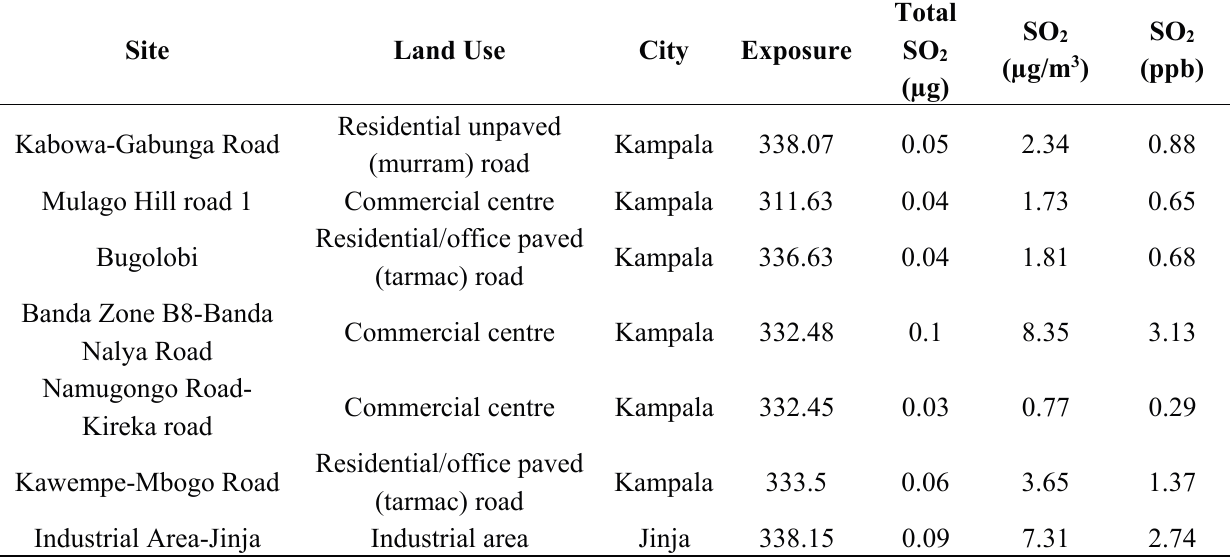
Table S3. Concentration of Sulphur dioxide at sites with detectable Sulphur dioxide concentrations. Site Land Use City Exposure